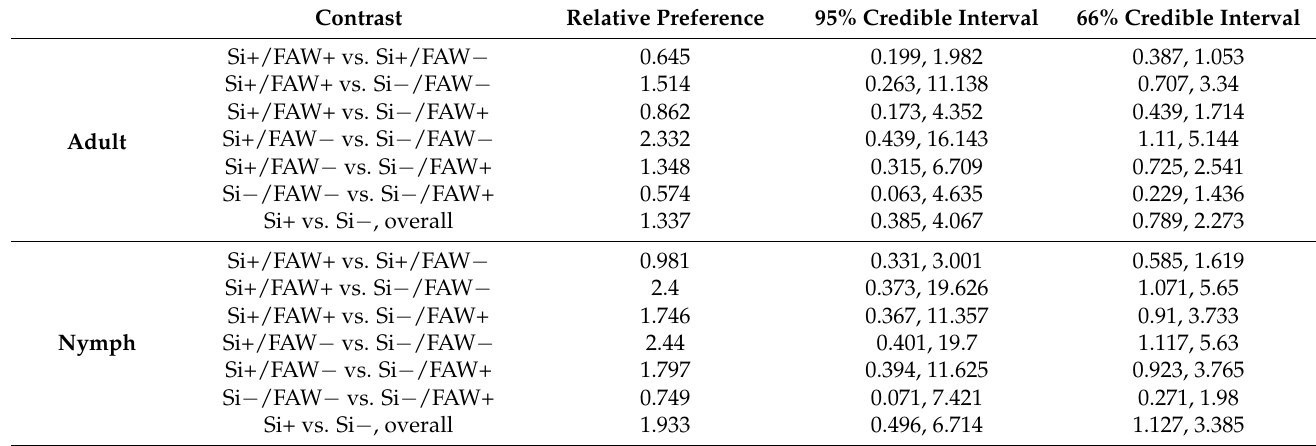
Table 1. Pairwise treatment contrasts (relative preferences) for all pairs of treatments for adults and nymphs and for Si+ and Si − overall. Median posterior estimates of relative preference are given, along with the lower and upper bounds of the 95% and 66% credible intervals.